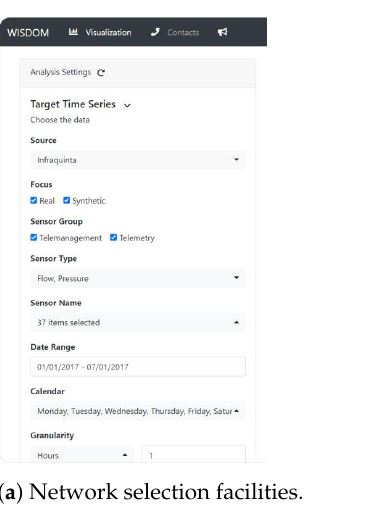
Figure 2. Decision support tool: parameterization component.